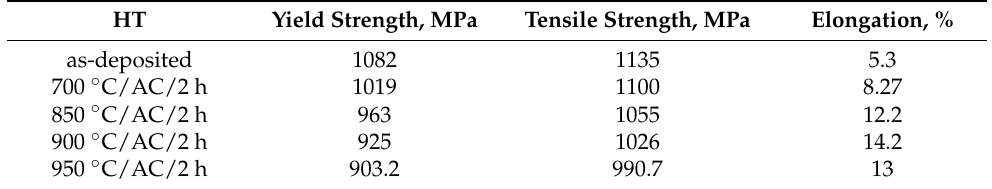
Table 2. The results of mechanical testing of deposited Ti-6Al-4V cylindrical samples with different HT